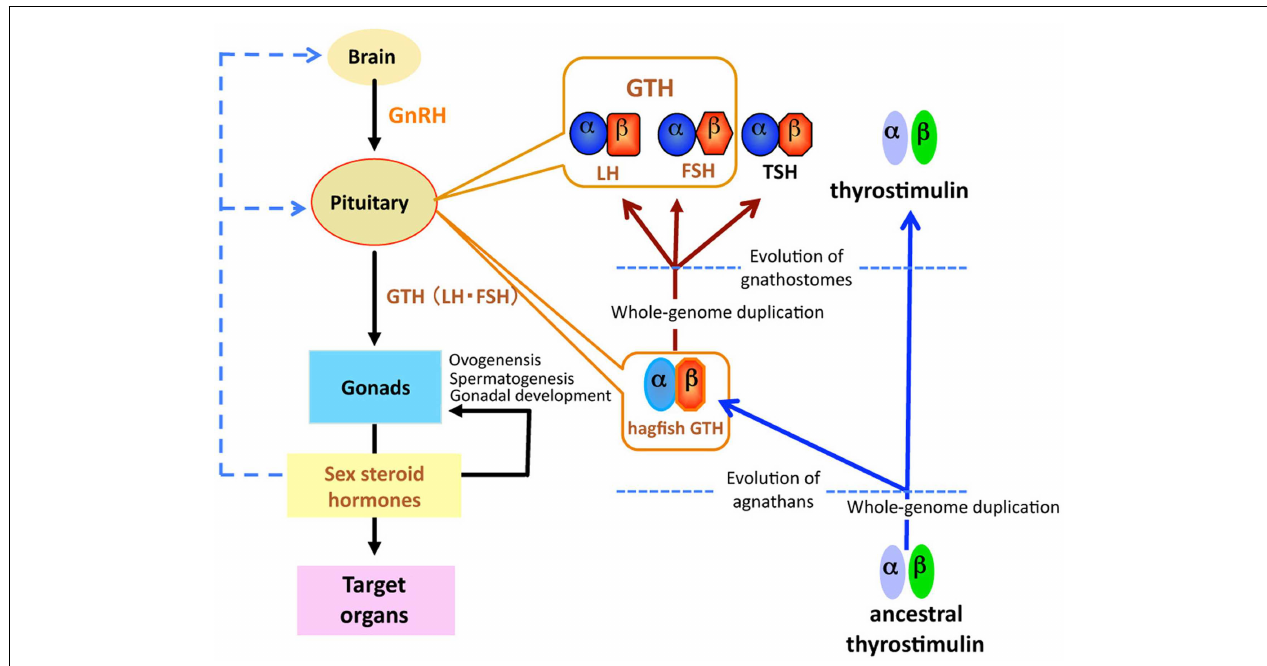
heterodimer in the pituitary and acted as the first adenohypophysial gonadotropic hormone during the evolution of agnathan species.This GTH dimer further diverged into three functional units of adenohypophysis, LH and FSH as two gonadotropins, andTSH as a thyrotropin, in the lineage to